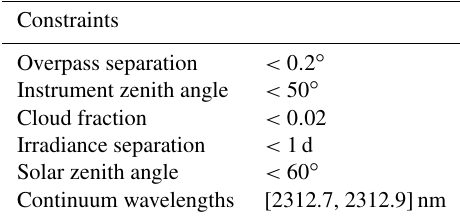
Table 2. Constraints used for monitoring of the TROPOMI-SWIR